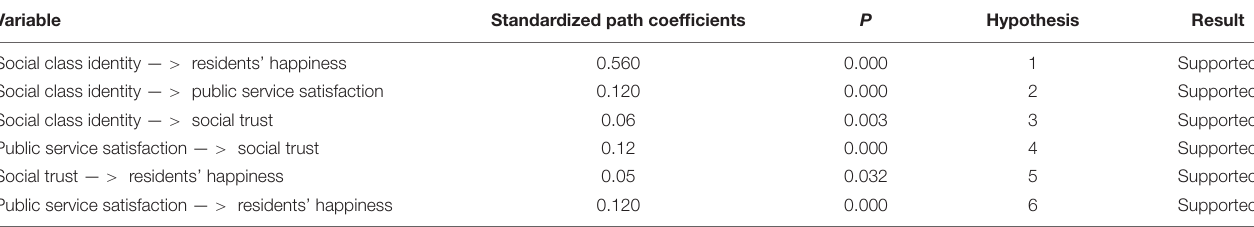
TABLE 5 | Hypothesis test results of path coefficients of structural equation model.